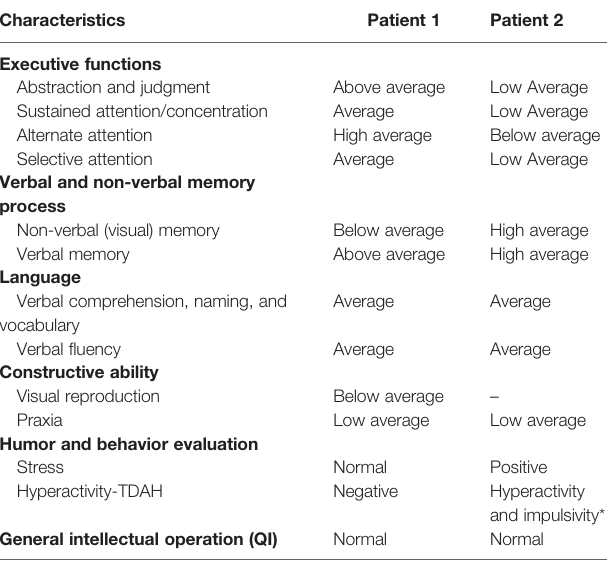
TABLE 2 | Summary of the neuropsychological evaluation results of the dyshormonogenetic fetal goiter patients using WISC-IV Tests.